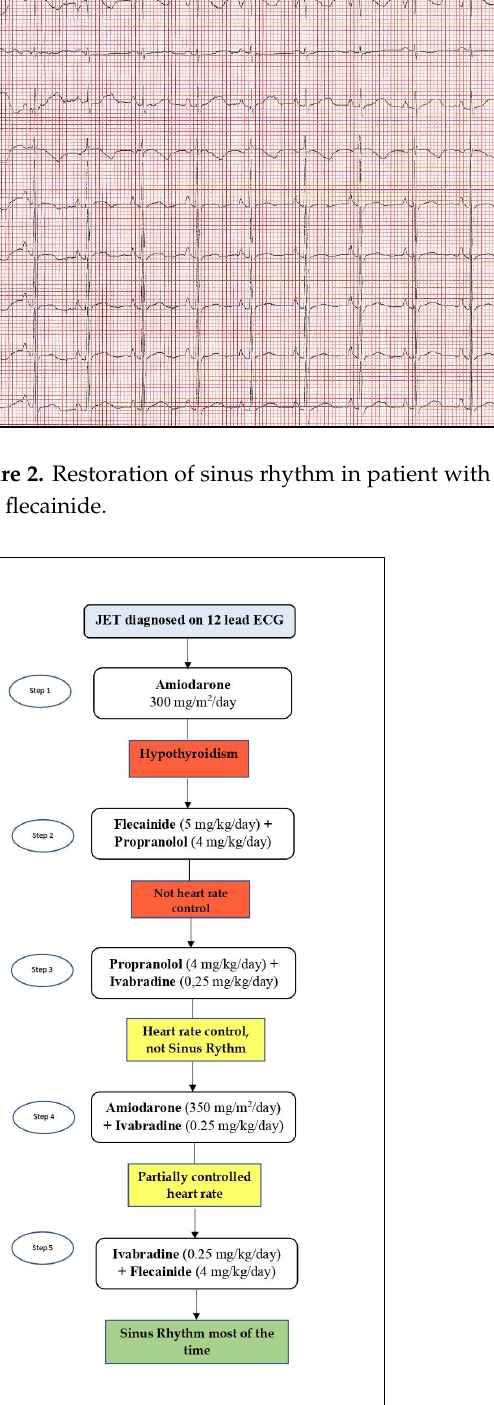
Figure 3. CJET management in our case, step by step.